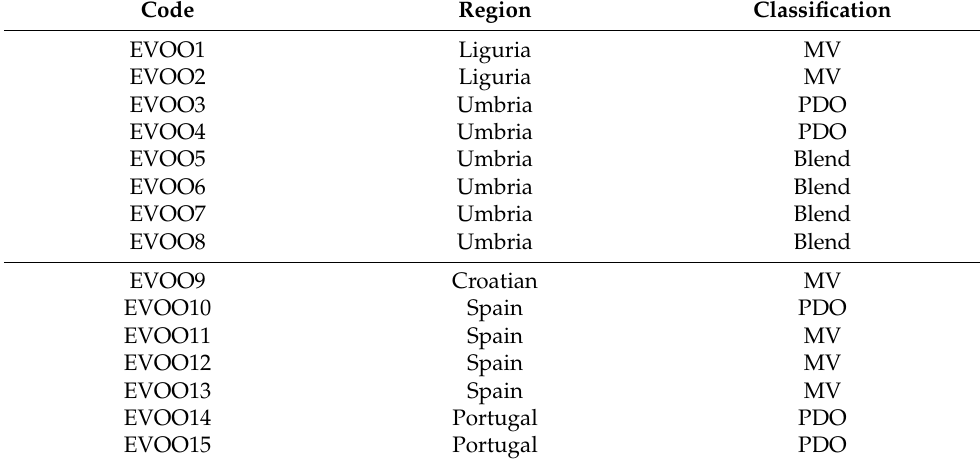
Table 1. List of EVOOs